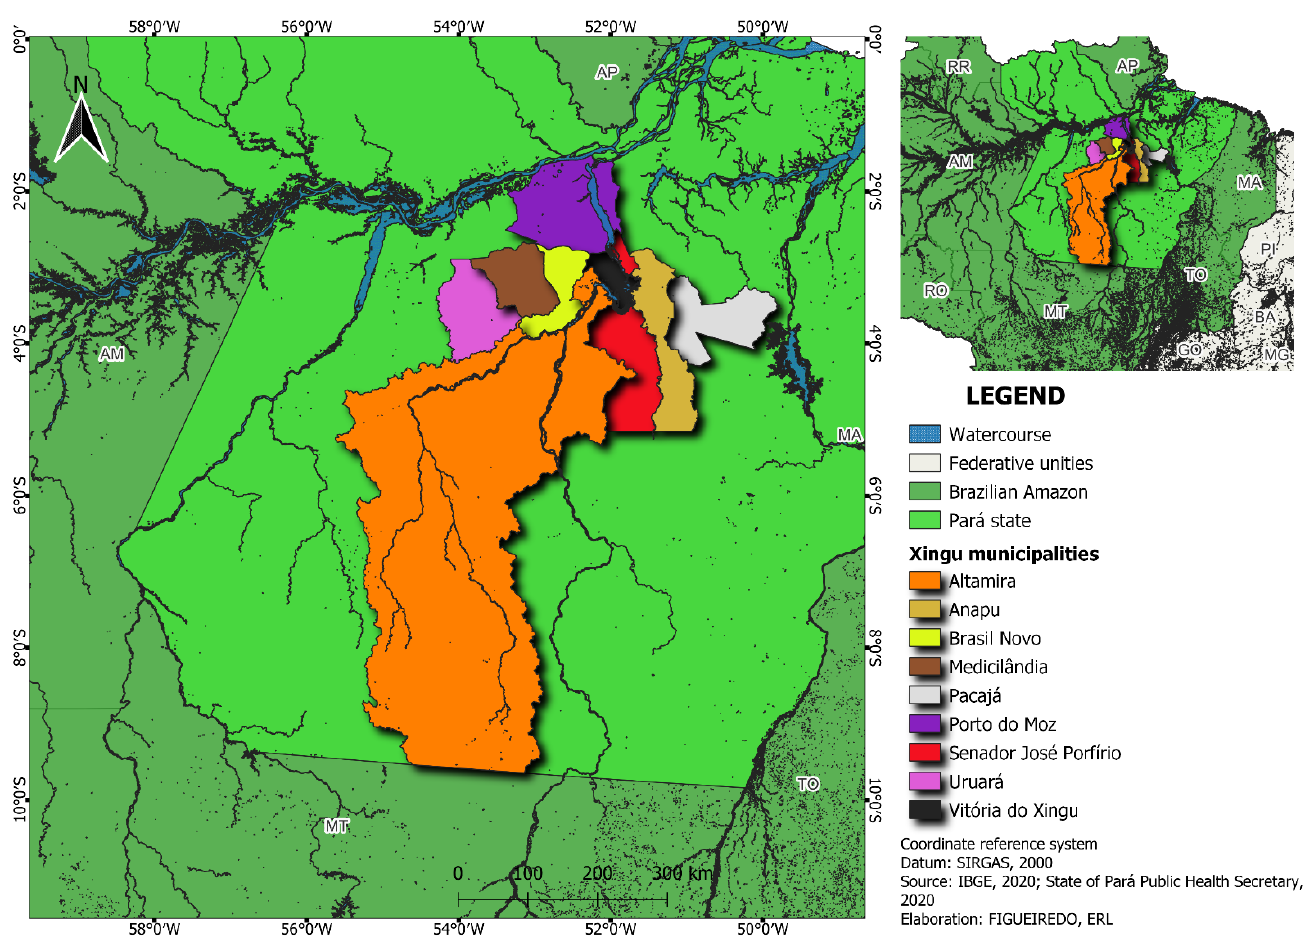
Figure 1. Map of the Xingu Health Region.